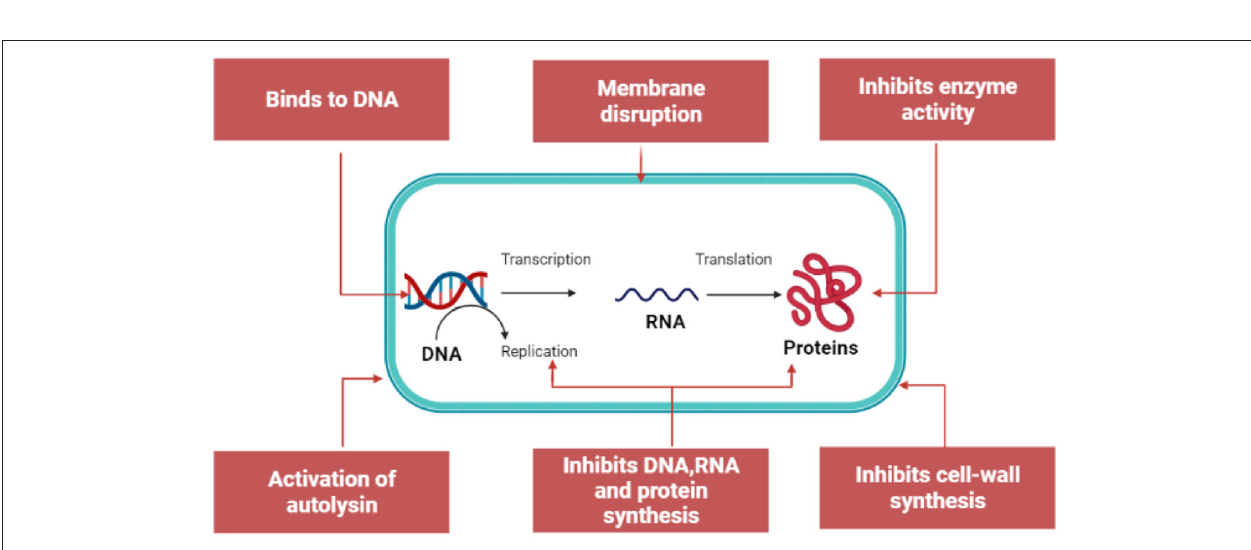
FIGURE 3 | The interaction between peptide and bacterial cellular membrane. The image was created using BioRender illustrator (https://Biorender.com/).